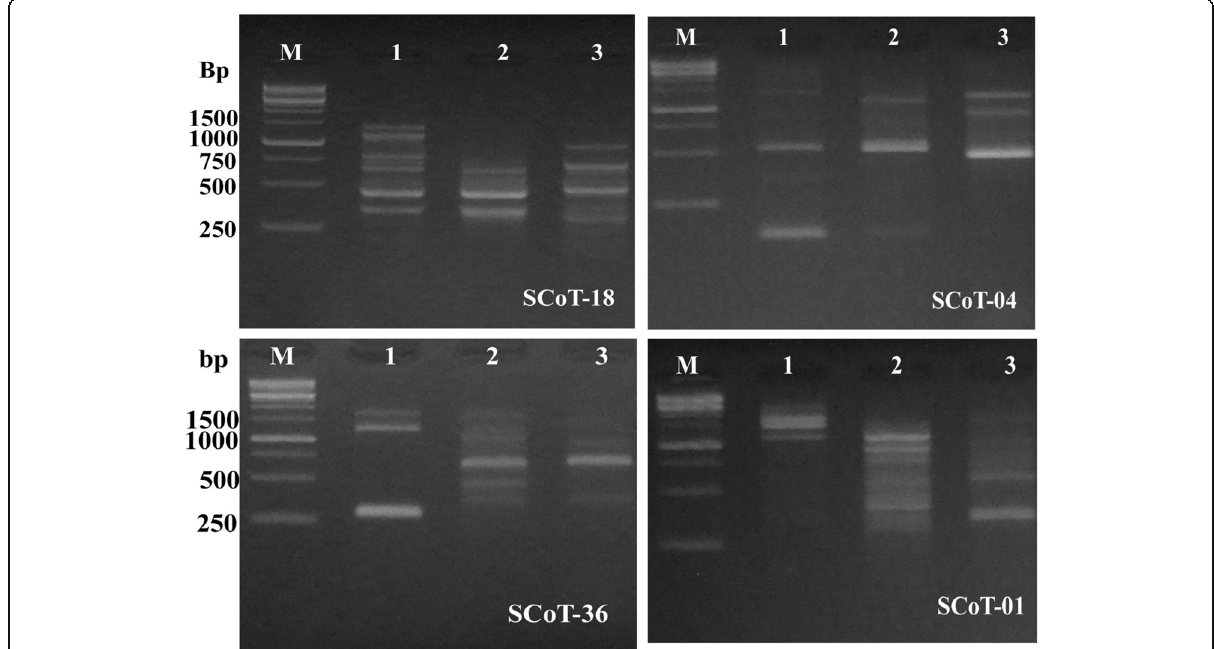
Fig. 3 Genetic polymorphism among the three isolates that belong to the family Heterorhabditis indica as revealed by the SCoT analysis. M, 1 kbp plus DNA ladder; 1 – 3, the nematode isolates (1, ERSAG; 2, H. indica Aborawash; 3, ERSAG2)